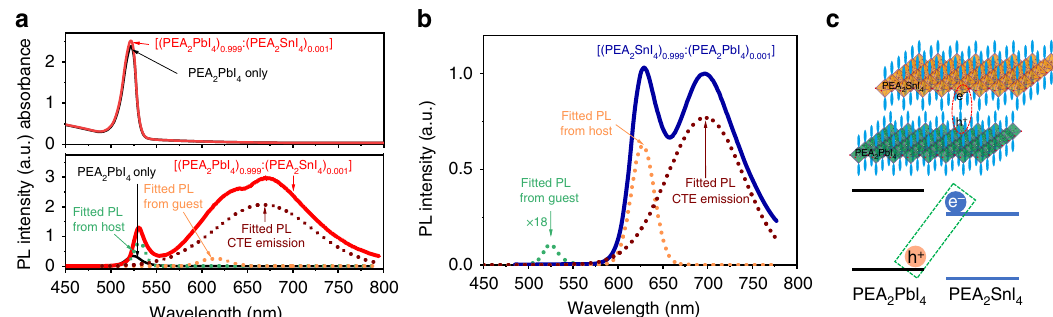
Fig. 1 Optical characteristics of CTE formation in 2D perovskite heterostructures. a Absorption and PL spectra are shown for 2D perovskite heterostructured [(PEA 2 PbI 4 ) 0.999 :(PEA 2 SnI 4 ) 0.001 ] fi lm. The absorption spectrum indicates that the bandgap is governed by the host (PEA 2 PbI 4 ) component in the heterostructures. The PL spectrum is dominated by a broad emission peaked at 669 nm with a spectral shoulder at 614 nm from the guest (PEA 2 SnI 4 ) and the intrinsic emission (peaked at 531 nm) from the host (PEA 2 PbI 4 ). b PL spectrum is shown for 2D perovskite heterostructured [(PEA 2 SnI 4 ) 0.999 :(PEA 2 PbI 4 ) 0.001 ] fi lm after switching host and guest components. The broad emission is observed with the peak position at 697nm, in addition to intrinsic emission (peaked at 524 and 627 nm) from host (PEA 2 PbI 4 ) and guest (PEA 2 SnI 4 ) components. The PL spectra for pristine PEA 2 PbI 4 and PEA 2 SnI 4 fi lms are also shown as reference. c Schematic diagram illustrates the formation of CTEs at the interfaces between PEA 2 PbI 4 and PEA 2 SnI 4